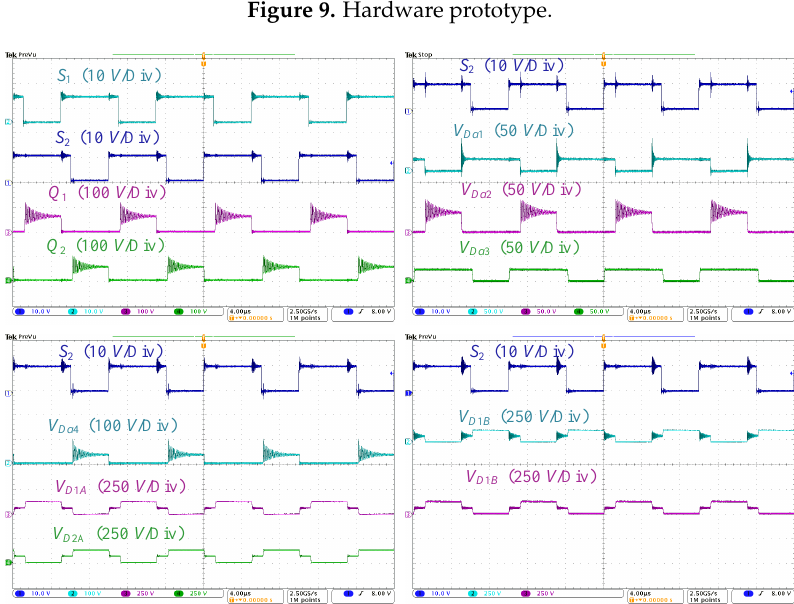
Figure 9. Hardware prototype.